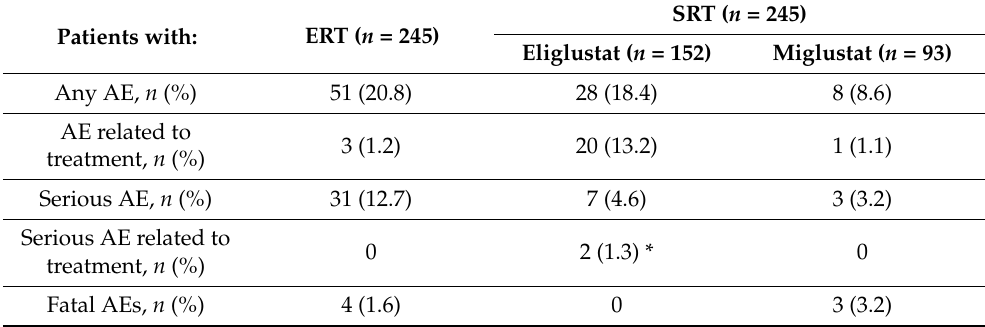
Table 2. Summary of patients experiencing adverse